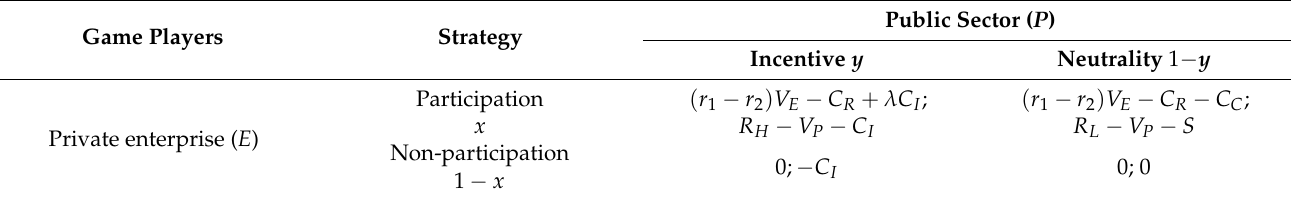
Table 1. Payoff matrix between the public and private